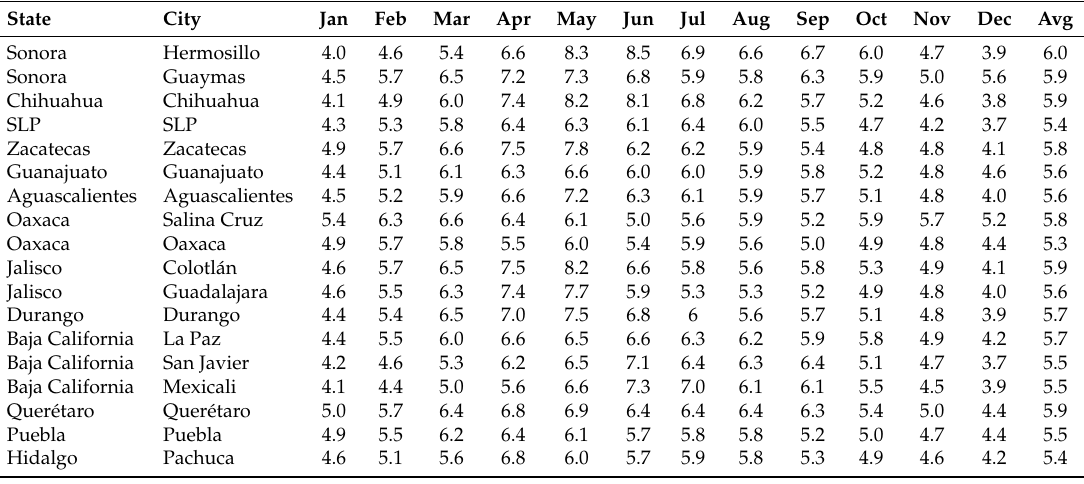
Table 1. The solar radiation on select places in Mexico (data in kWh/m 2 per day) [37].